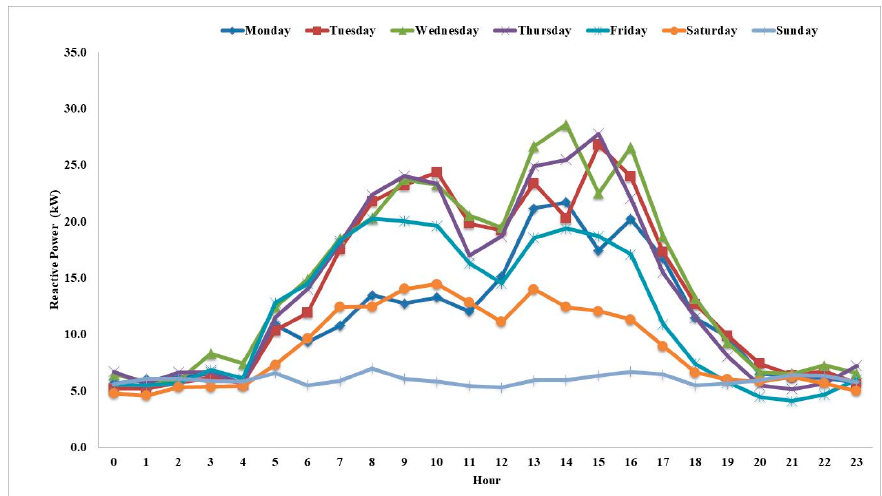
Figure 11. Reactive Power Consumption.